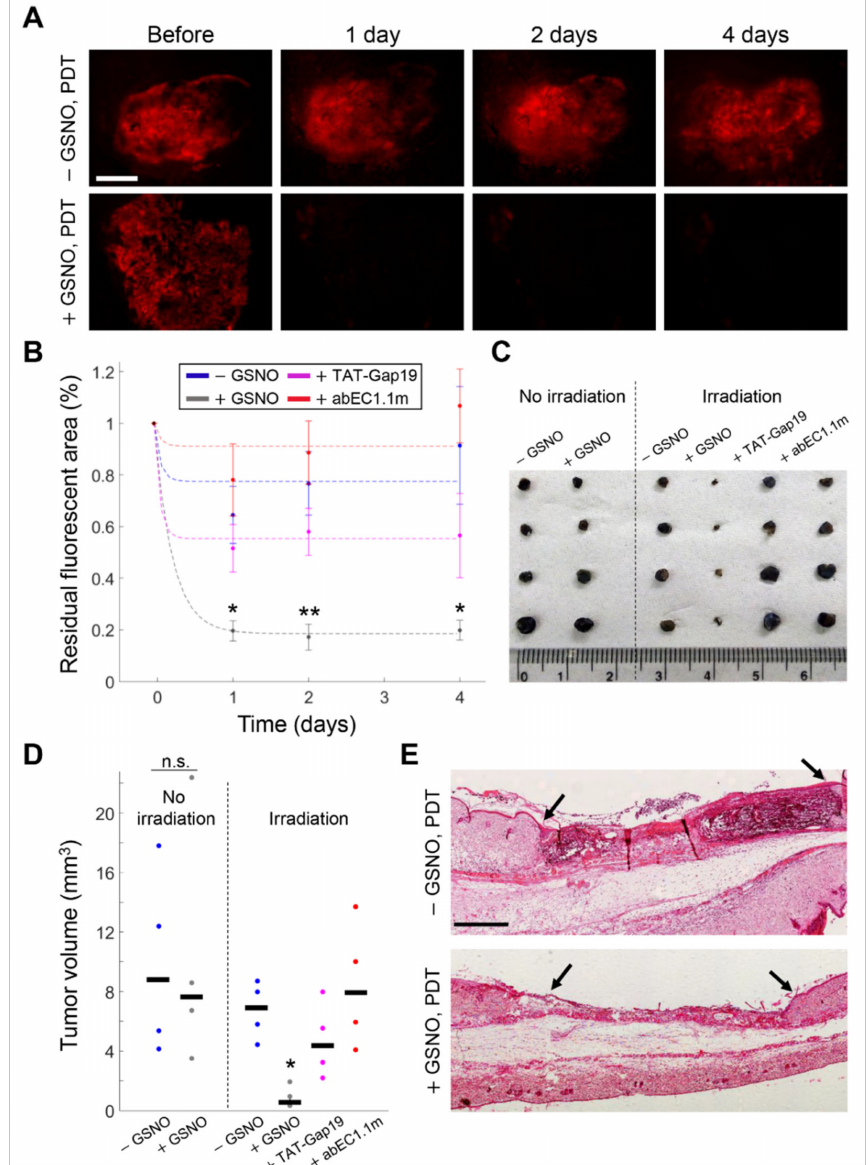
Figure 6. Microinjected S-Nitrosoglutathione (GSNO) enhances the efficacy of full photodynamic therapy (PDT) in murine melanoma by activating connexin hemichannels. ( A ) Photosensitizer (PS)-loaded melanomas grown in the dorsal skinfold chamber (DSC) and expressing mCherry were irradiated (full PDT, 60 min, irradiance ~245 mW/cm 2 ) 20 min after microinjection of: normal extracellular medium (NEM, control conditions: − GSNO); GSNO (1 mM) dissolved in NEM (+GSNO); GSNO (1 mM) plus TAT-Gap19 (150 µ M, +TAT-Gap19) dissolved in NEM or abEC1.1m (2 µ M, +abEC1.1m) dissolved in NEM; tumor cell demise was assayed by time-lapse microscopy of red fluorescent mCherry. Shown are representative images acquired before and after full PDT in − GSNO and +GSNO conditions at shown time points; scale bar: 1 mm; ( B ) Melanoma surface area with persistent mCherry post-irradiation fluorescence in − GSNO (blue, n = 4), +GSNO (gray, n = 4), +TAT-Gap19 (magenta, n = 4) and +abEC1.1m (red, n = 4) conditions. Interpolating curves (dashed lines) are data fitting with the function f( t ) =1 − a + ae − b ( t + c ) (for parameter values see Table S5). *, p < 0.05; **, p < 0.01, the Mann-Whitney U test; ( C – E ) Melanomas were harvested 4 days after treatment. Controls were loaded with PS and microinjected but were not irradiated (No irradiation); ( C ) Tumor masses excised after treatment in each of the six conditions, scale unit: cm; ( D ) Tumor volumes measured by micro-computed tomography analysis; black horizontal bars mark the median. n.s., not significant; *, p < 0.05, the Kruskal-Wallis test (for post hoc pairwise comparisons see Table S6); ( E ) Hematoxylin and eosin staining of tumor-bearing DSC tissues exposed to full PDT in − GSNO or +GSNO conditions. Black arrows mark the edges of punch biopsies where B16-F10 melanoma cells were seeded; scale bar: 1